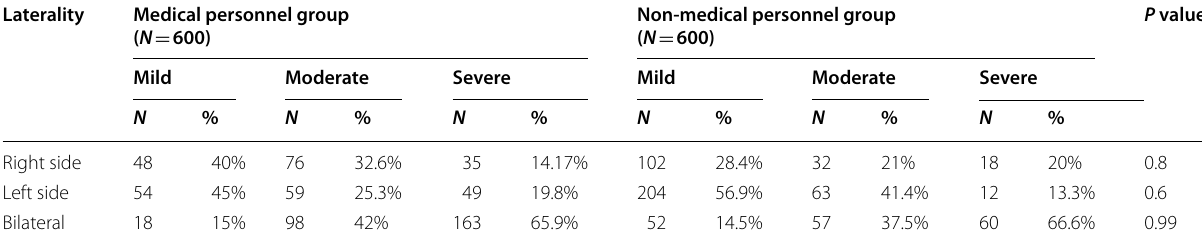
Table 5 Comparison between medical personnel and non-medical personnel groups, as regards laterality of lung involvement ( N 1200) =